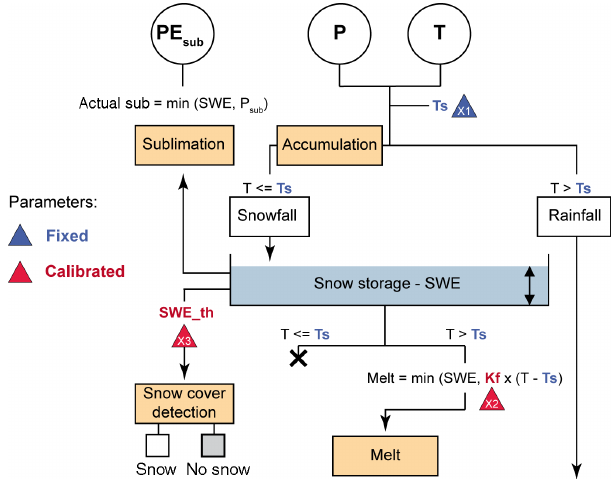
Figure 4. Distributed degree-day model used in the study (Ruelland et al.,